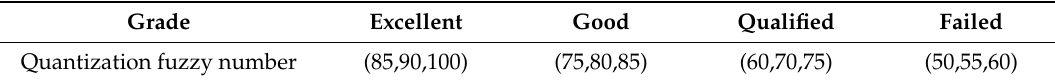
Table 7. Quantitative standard for qualitative index of distribution